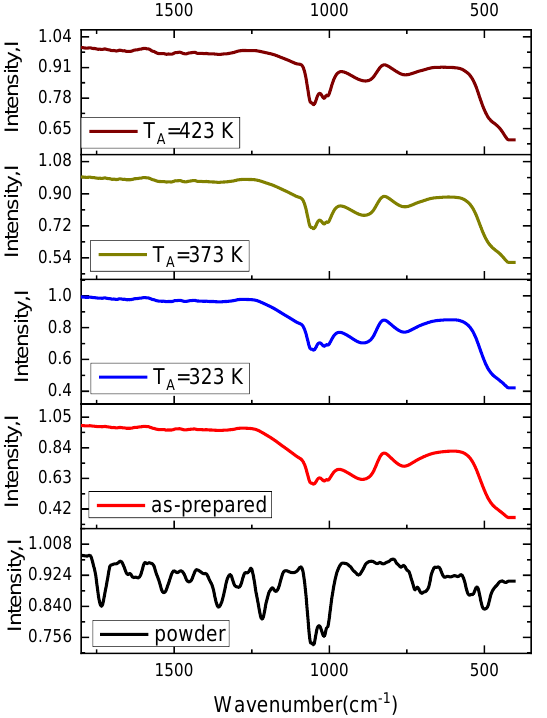
Figure 8. Infrared spectra of powder, as-deposited thin film, and annealed film (at 323K, 373K, and 423 K for 3 hours in air) of compound 4 .